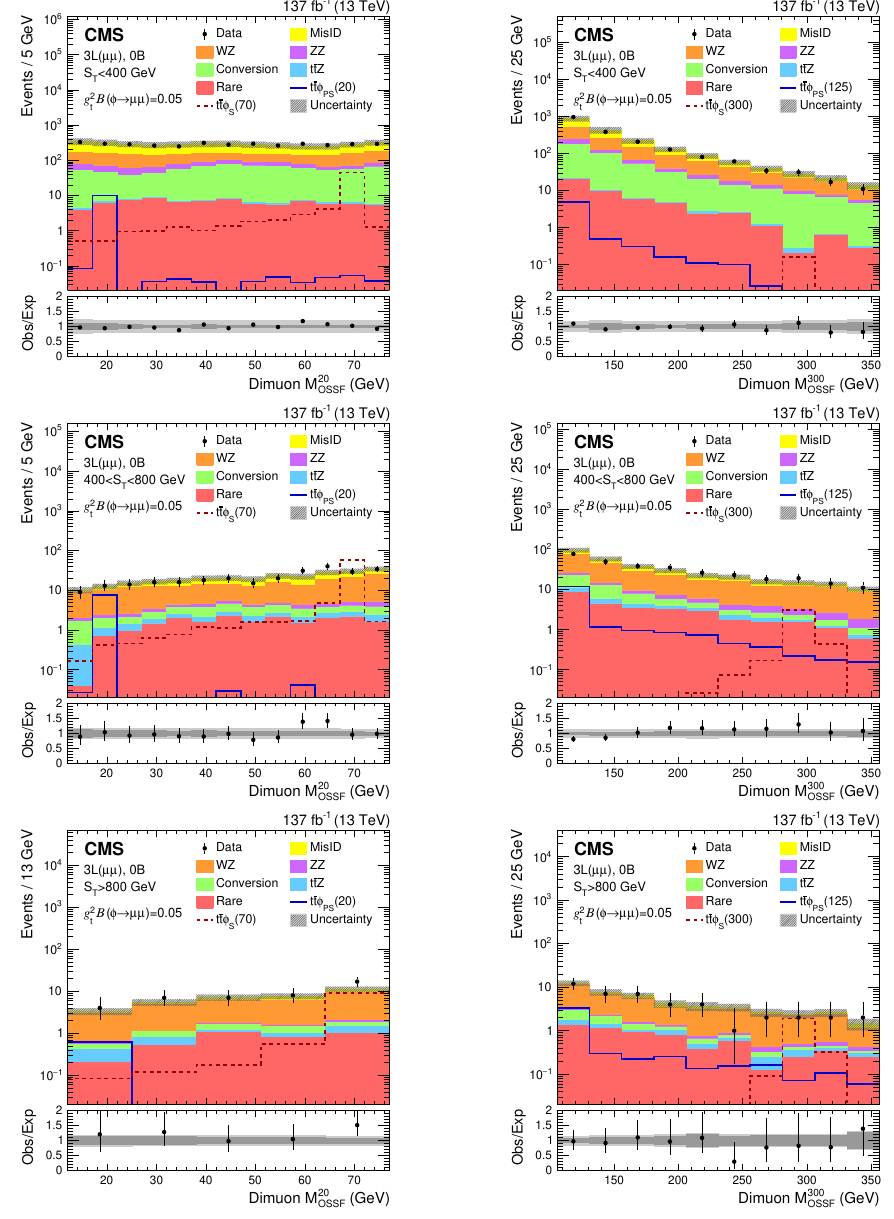
Figure 8 . Dimuon M 20 (left column) and M 300 (right column) distributions in the 3L( (cid:22)(cid:22) ) OSSF OSSF 0B tt (cid:30) signal regions. Upper, center, and lower plots are for S < 400 GeV, 400 < S < 800 GeV, T T and S > 800 GeV, respectively. The total SM background is shown as a stacked histogram of all T contributing processes. The predictions for tt (cid:30) ( ! (cid:22)(cid:22) ) models with a pseudoscalar (scalar) (cid:30) of 20 B ( (cid:30) ! (cid:22)(cid:22) ) = 0 : 05 are also shown. The lower panels and 125 (70 and 300) GeV mass assuming g 2 t show the ratio of observed to expected events. The hatched gray bands in the upper panels and the light gray bands in the lower panels represent the total (systematic and statistical) uncertainty of the backgrounds in each bin, whereas the dark gray bands in the lower panels represent only the statistical uncertainty of the backgrounds. The rightmost bins do not contain the over(cid:13)ow events as these are outside the probed mass range.